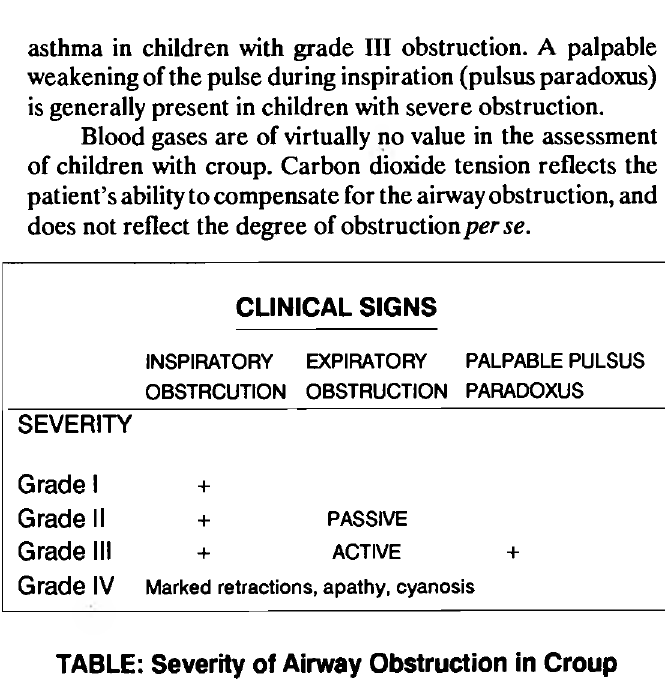
TABLE: Severity of Airway Obstruction in